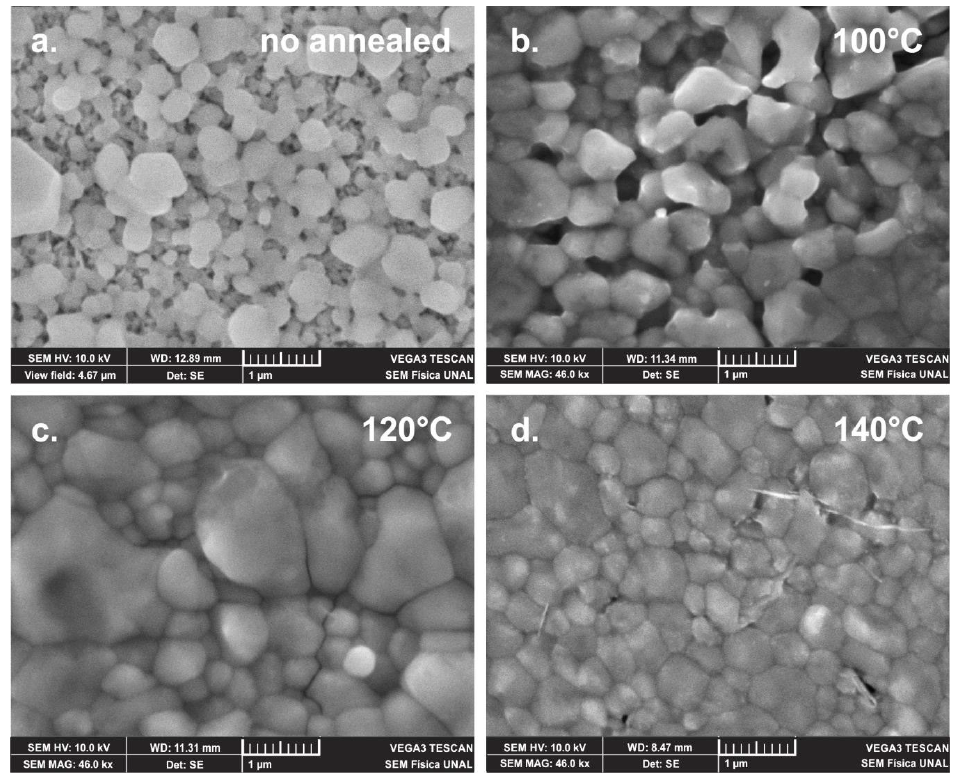
Figure 11. SEM images of MAPI films with composition corresponding to a PbI 2 / MAI thickness ratio of 3:1, ( a ) no annealed, and at annealed temperatures of ( b ) 100 °C, ( c ) 120 °C and ( d ) 140 °C.